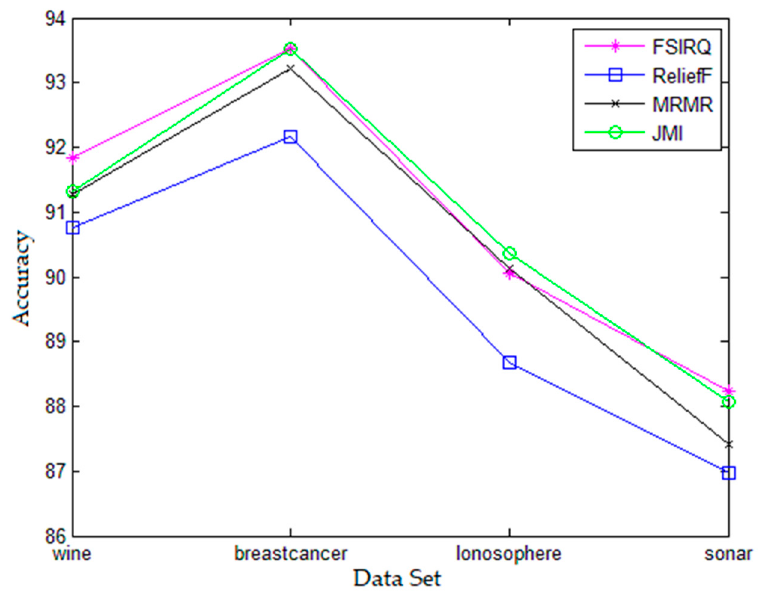
Figure 3. Comparison of Algorithm Accuracy Rates